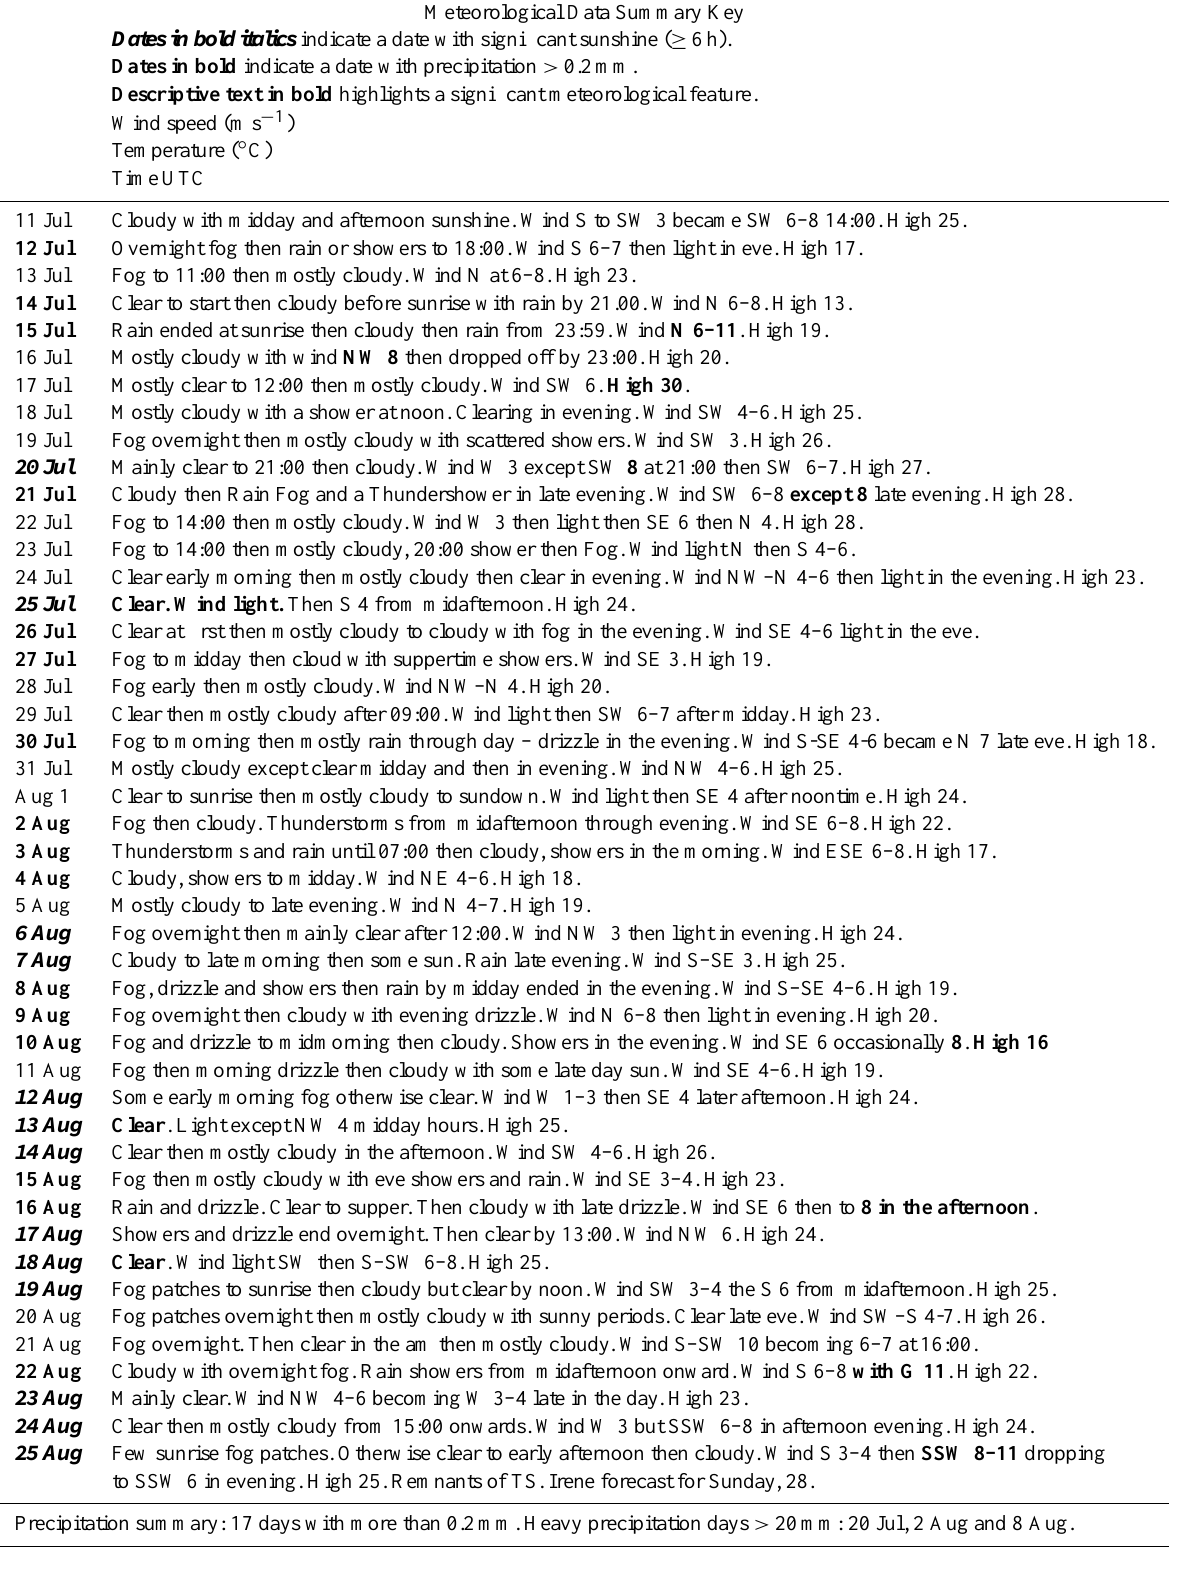
Table 2. Daily meteorological summary covering the filter sampling period 11 July 2011 to 25 August 2011 from Halifax International Airport. Meteorological Data Summary